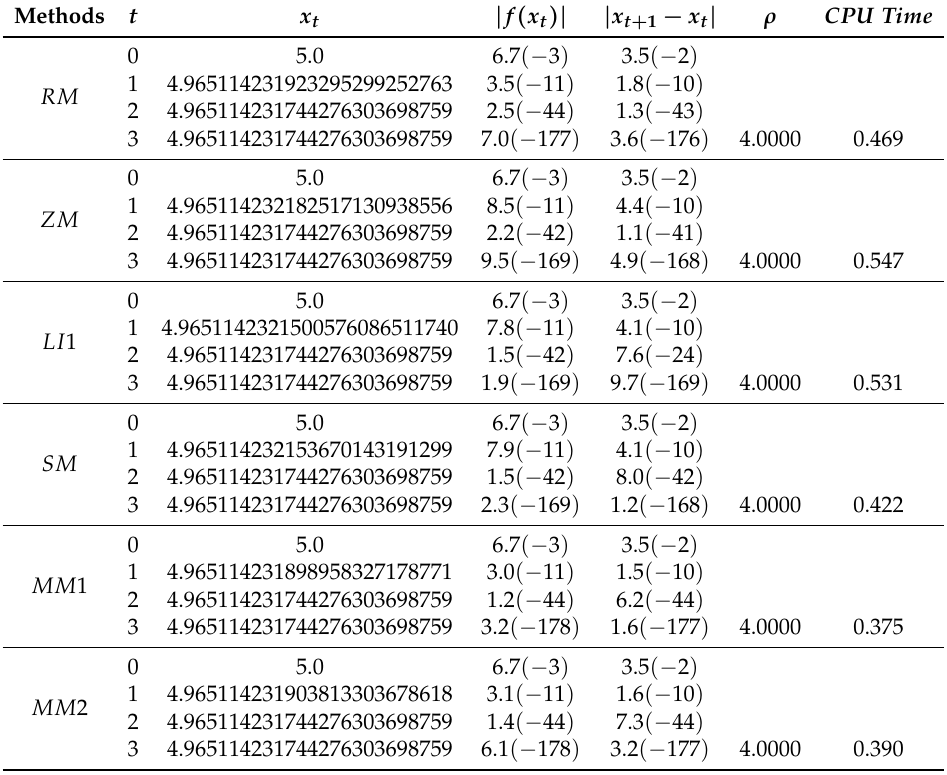
Table 2. Outcomes for comparison by testing schemes on Example